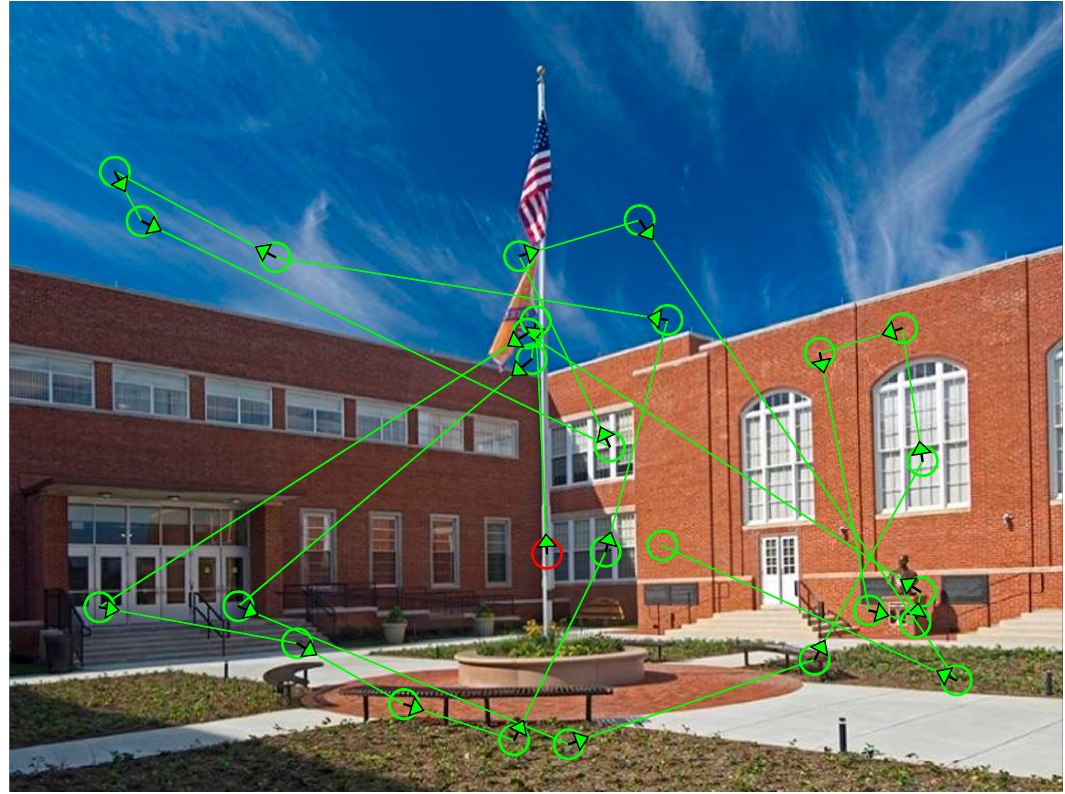
Figure 1. Scan pattern of a single viewer freely viewing a real-world scene.